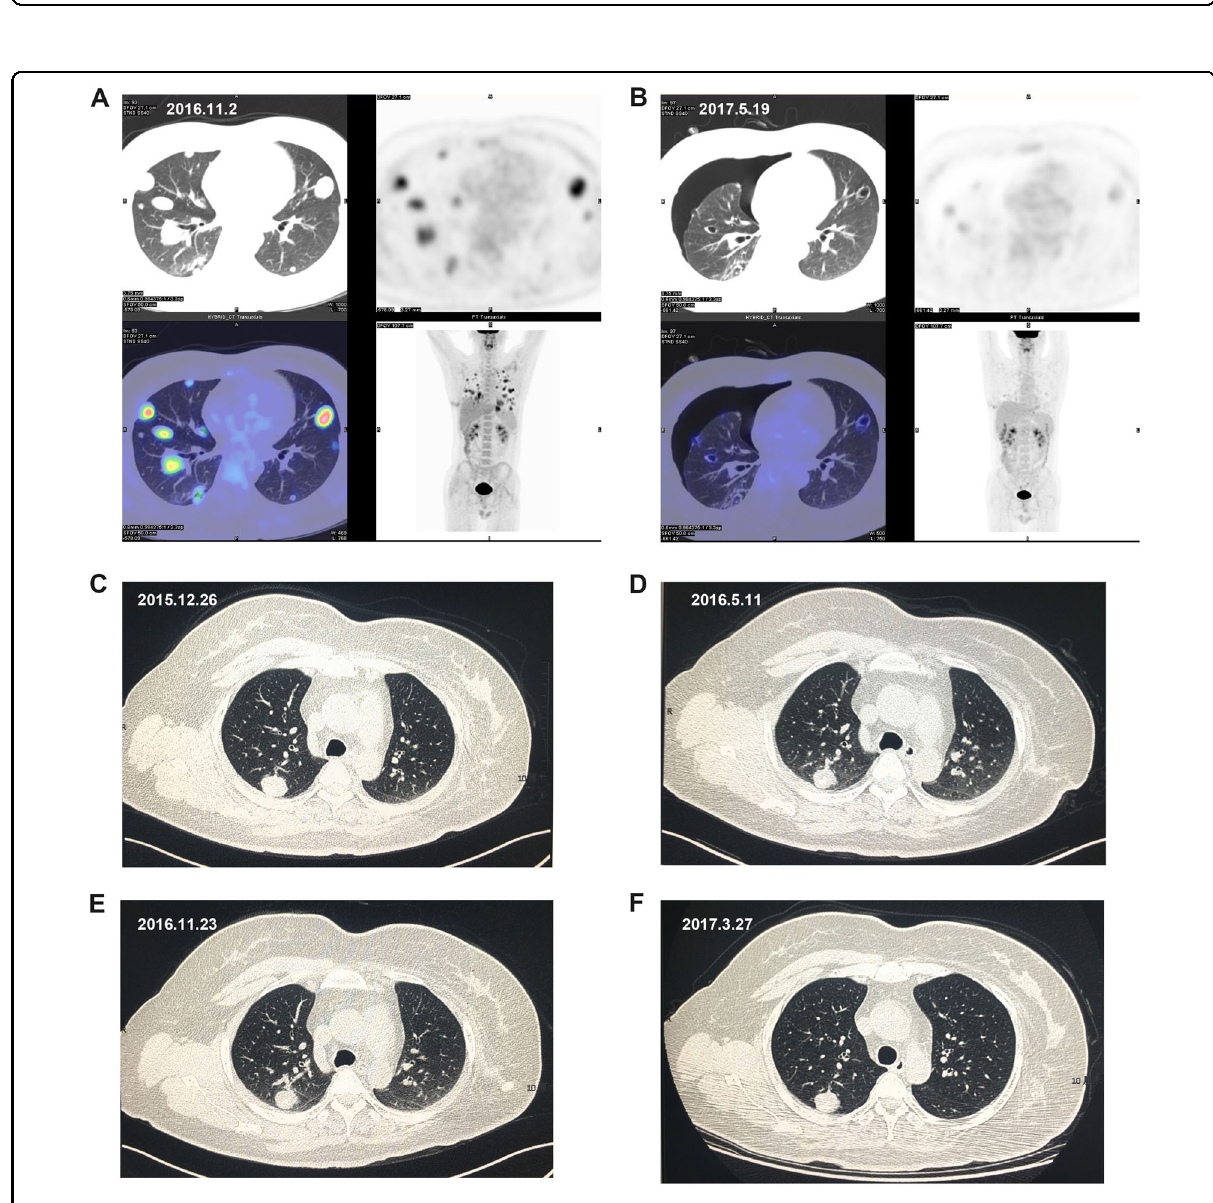
Fig. 3 Typical responses to apatinib treatment in two sarcoma patients. a , b Metastatic undifferentiated pleomorphic sarcoma lesions showed signi fi cant decrease in size and pulmonary cavities after apatinib treatment. Positron emission tomography-computed tomography (PET-CT) showed decreased tumor size, metabolic activity, pulmonary cavities, and severe pneumothorax after apatinib treatment. a Before apatinib treatment (2016.11.2). b After apatinib treatment (2017.5.19). c – f Stable lung metastatic lesion in patient with synovial sarcoma treated with apatinib. Chest CT scan showed long-term stable disease. c : CT scan before treatment (2015.12.26). d CT scan after treatment (2016.5.11). e CT scan after treatment (2016.11.23). f CT scan after treatment (2017.3.27)